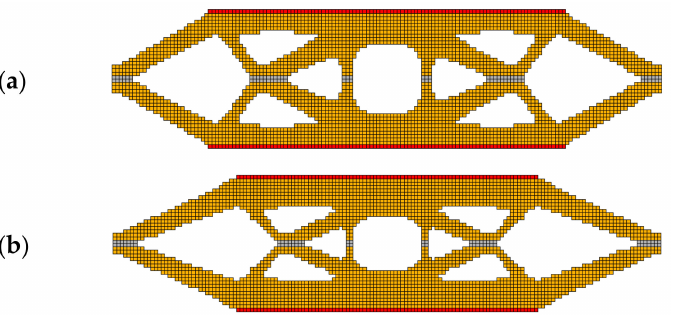
Figure 16. The final topologies for the FGM structure: E 1 —red color, E 2 —gray color, FGM— yellow color; SIMP interpolation scheme: ( a ) E 1 = 10 11 Pa E 2 = 2 × 10 11 Pa, minimal compliance: 11.514 × 10 − 4 Nm; ( b ) E 1 = 10 11 Pa E 2 = 10 12 Pa, minimal compliance: 6.532 × 10 − 4